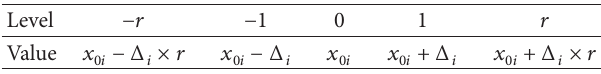
Figure 8: Diagram of the movement of circular tracking. Table 1: Code variable design level and the